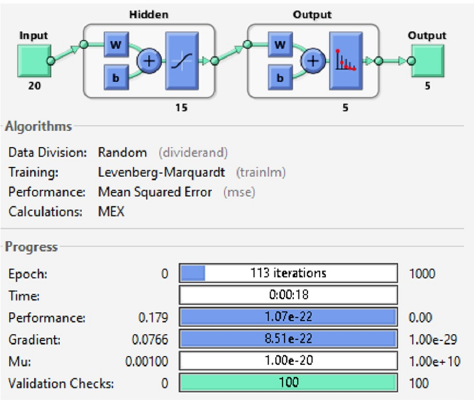
Figure 16. Architecture and training characteristics of the ANN. Note: In this figure 8 e + 3 represents 8 × 10 3 in scientific